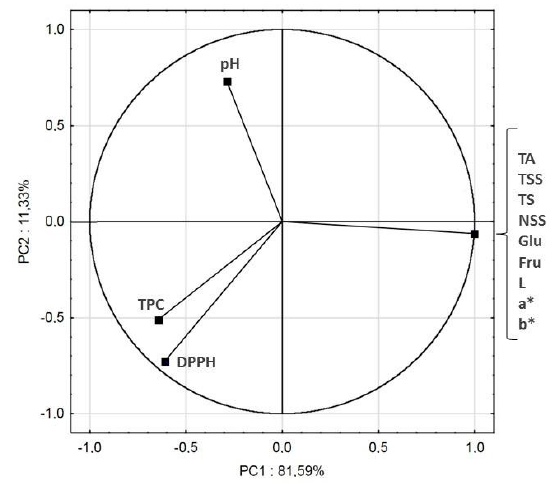
Figure 5. Principle component analysis of cloudy apple-cranberry juice processed by ultrafiltration and diafiltration, the response of 12 determined parameters.